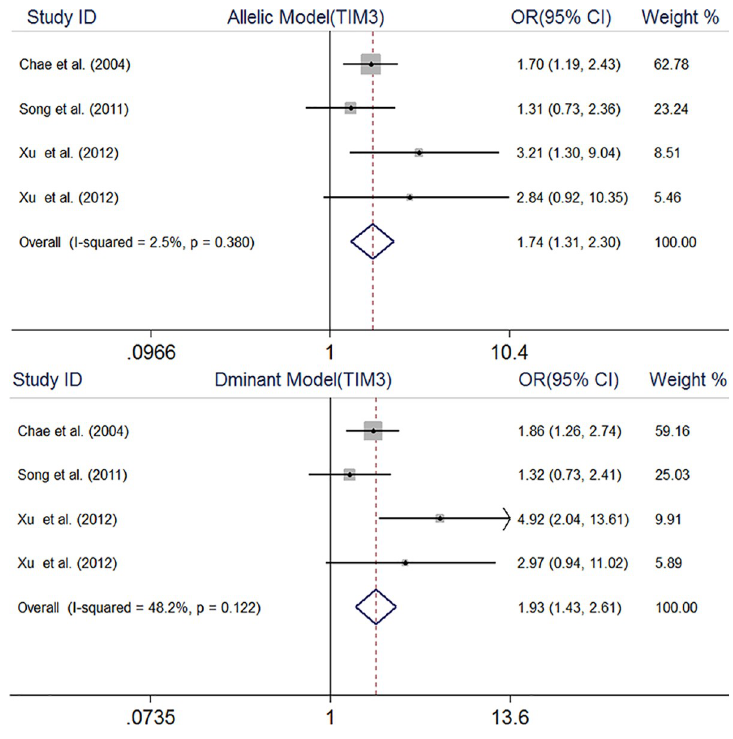
Fig 3. Forest plot of association between TIM3 rs1036199 gene polymorphism and rheumatoid arthritis.